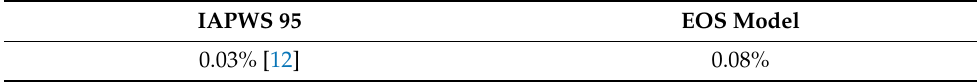
Table 1. Mean relative error ( MRE ) of the models 1 .